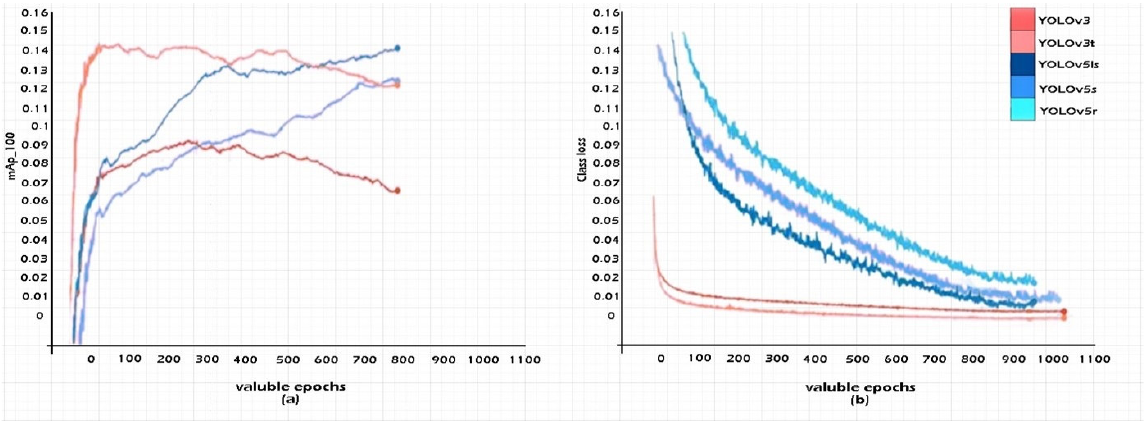
Figure 7. Simulation training results of YOLOv3, YOLOv3t, YOLOv5ls, YOLOv5s, and YOLOv5r on the SRI dataset. ( a ) mAPT at IoU = 60; ( b ) classification loss.